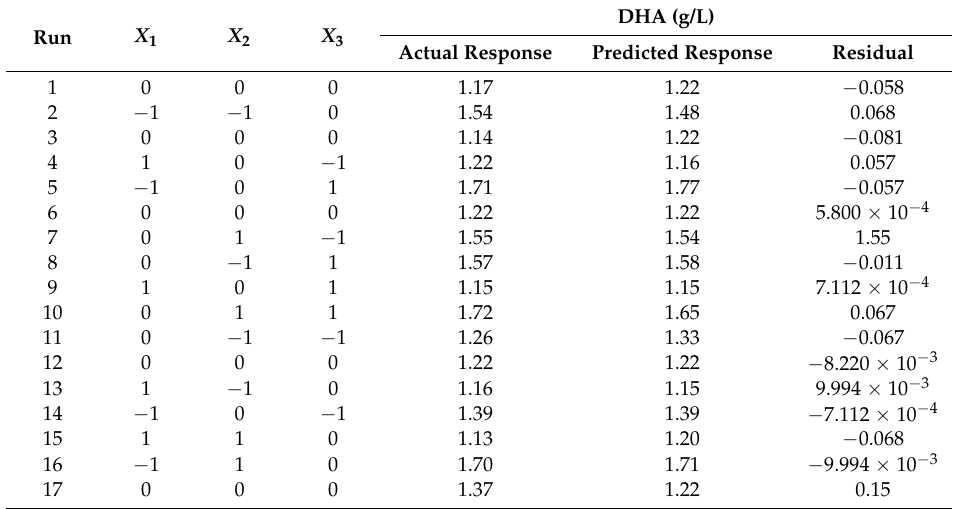
Table 4. The Box-Behnken design matrix for coded variables along with actual and predicted responses.